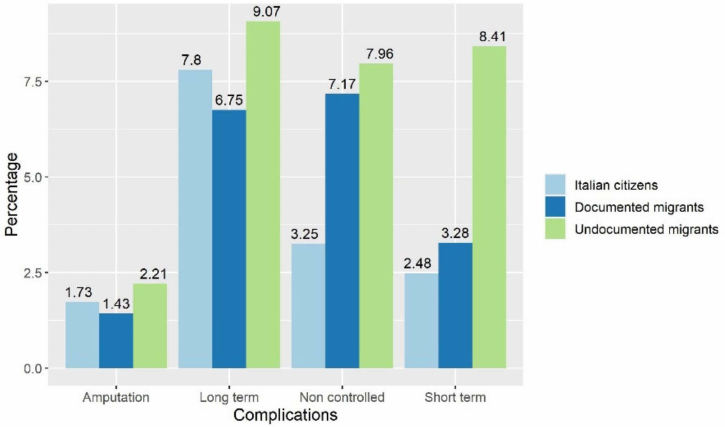
Figure 2. Percentage of preventable hospital admissions costs, by type and by population of